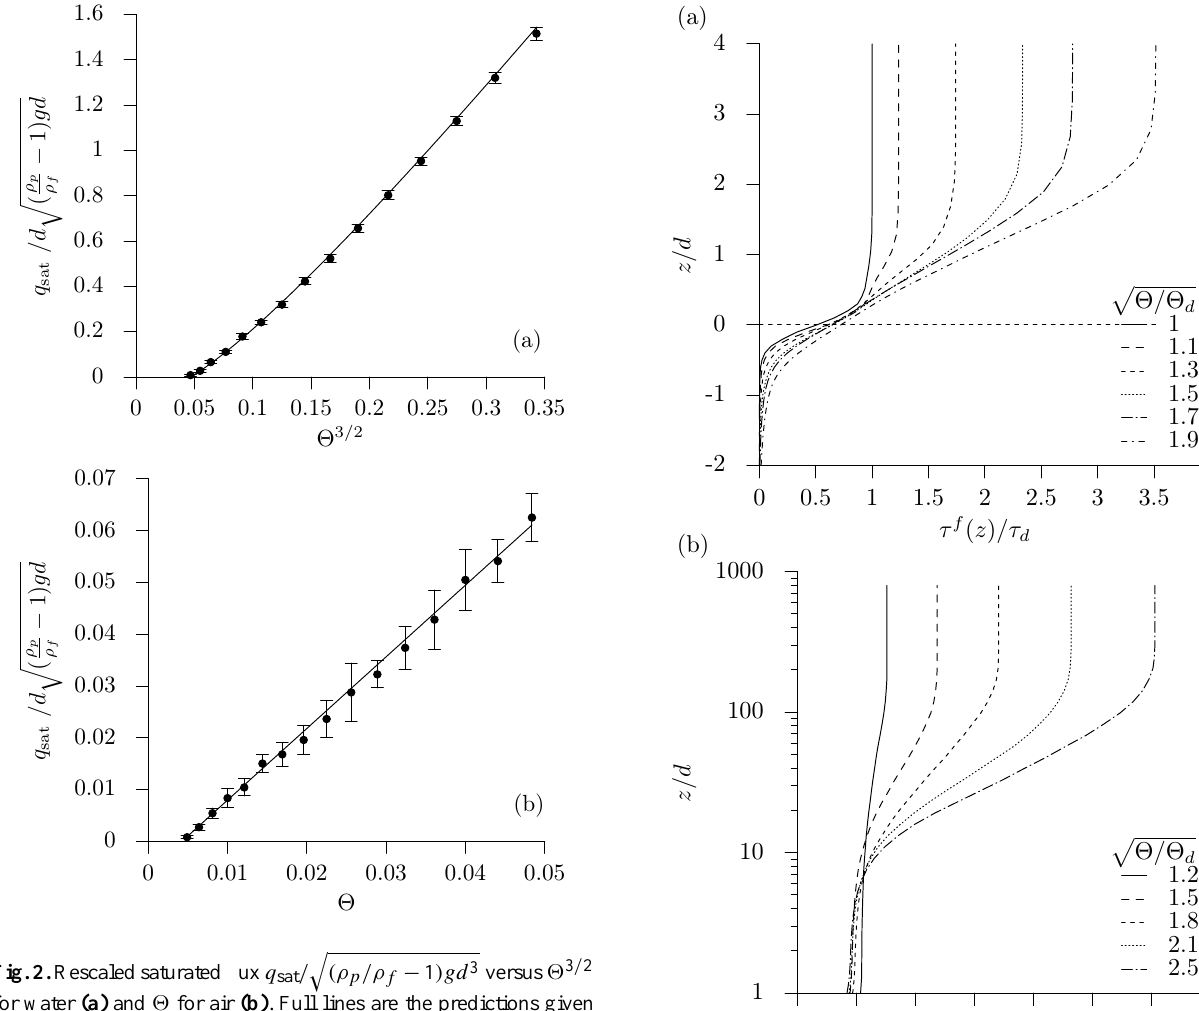
Fig. 2. Rescaled saturated flux q sat / for water (a) and 2 for air (b) . Full lines are the predictions given in the text.